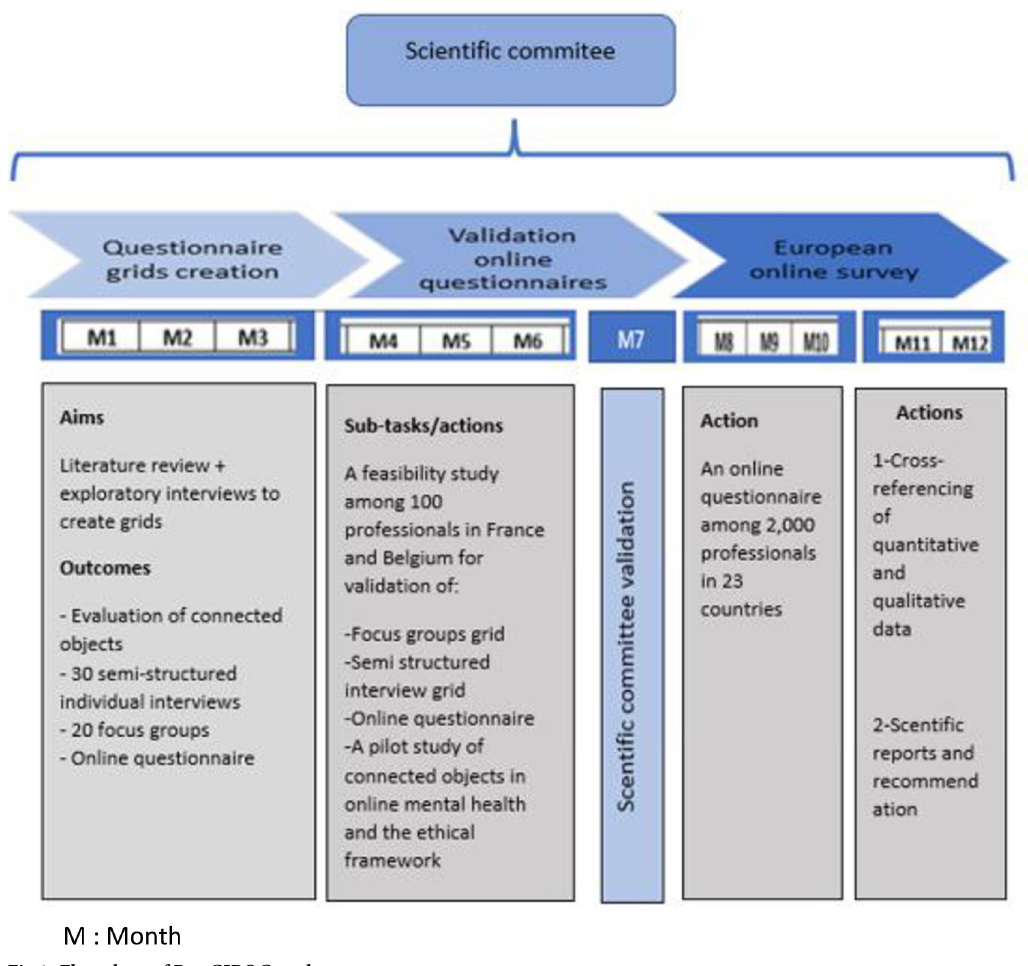
Fig 1. Flow chart of Psy-GIPOC